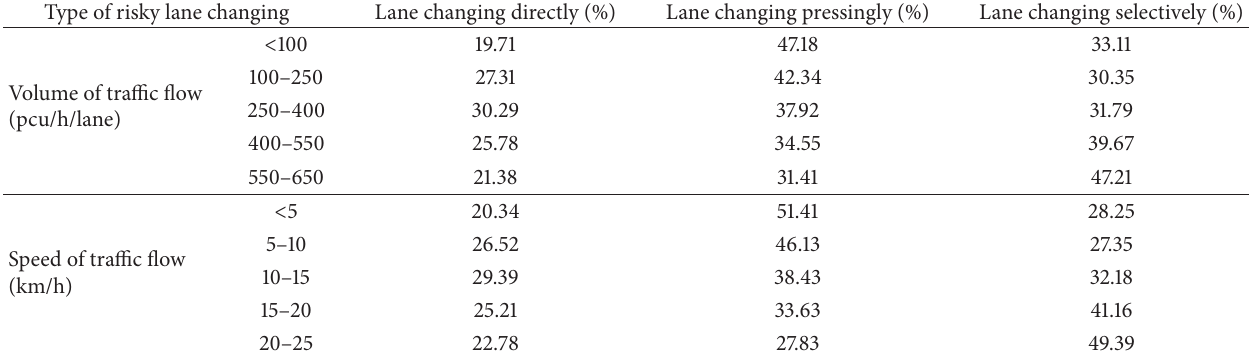
Table 8: Statistical analysis of risky lane changing behaviors via different traffic parameters.